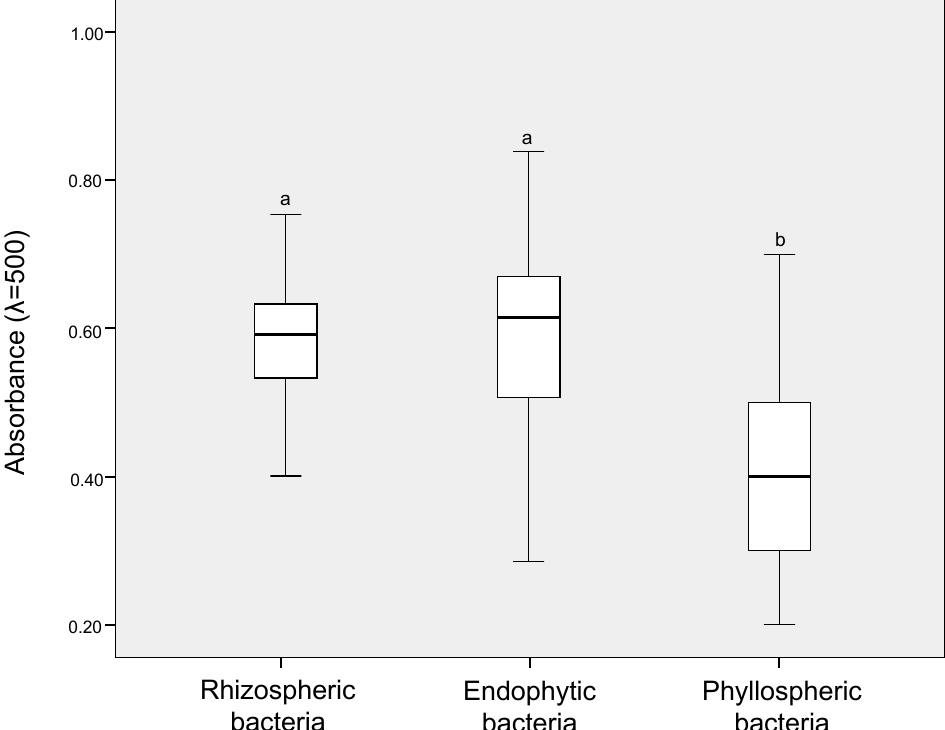
Figure 3. Boxplot of the putative ice-recrystallization-inhibition (IRI) activities of heterotrophic bacteria isolated from the rhizosphere, endosphere, and phyllosphere of Antarctic vascular plants. The centerline of each box represents the median, the top and bottom of boxes represent the 25th and 75th percentile of data, respectively, and the top and bottom of the error bars represent the 5th and 95th percentile of data, respectively. α -KB: α -ketobutyrate. Small letters indicate significant differences ( p ≤ 0.05) among samples.